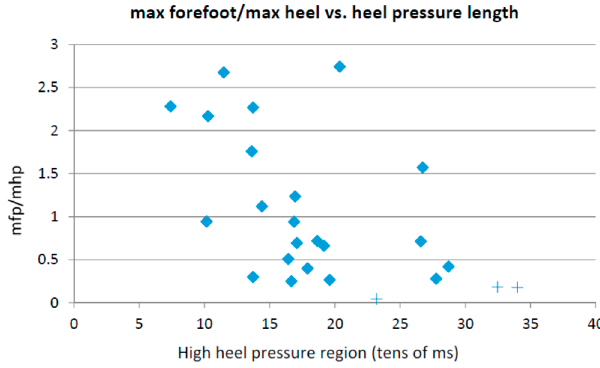
Figure 2. Maximum forefoot pressure vs. heel length.